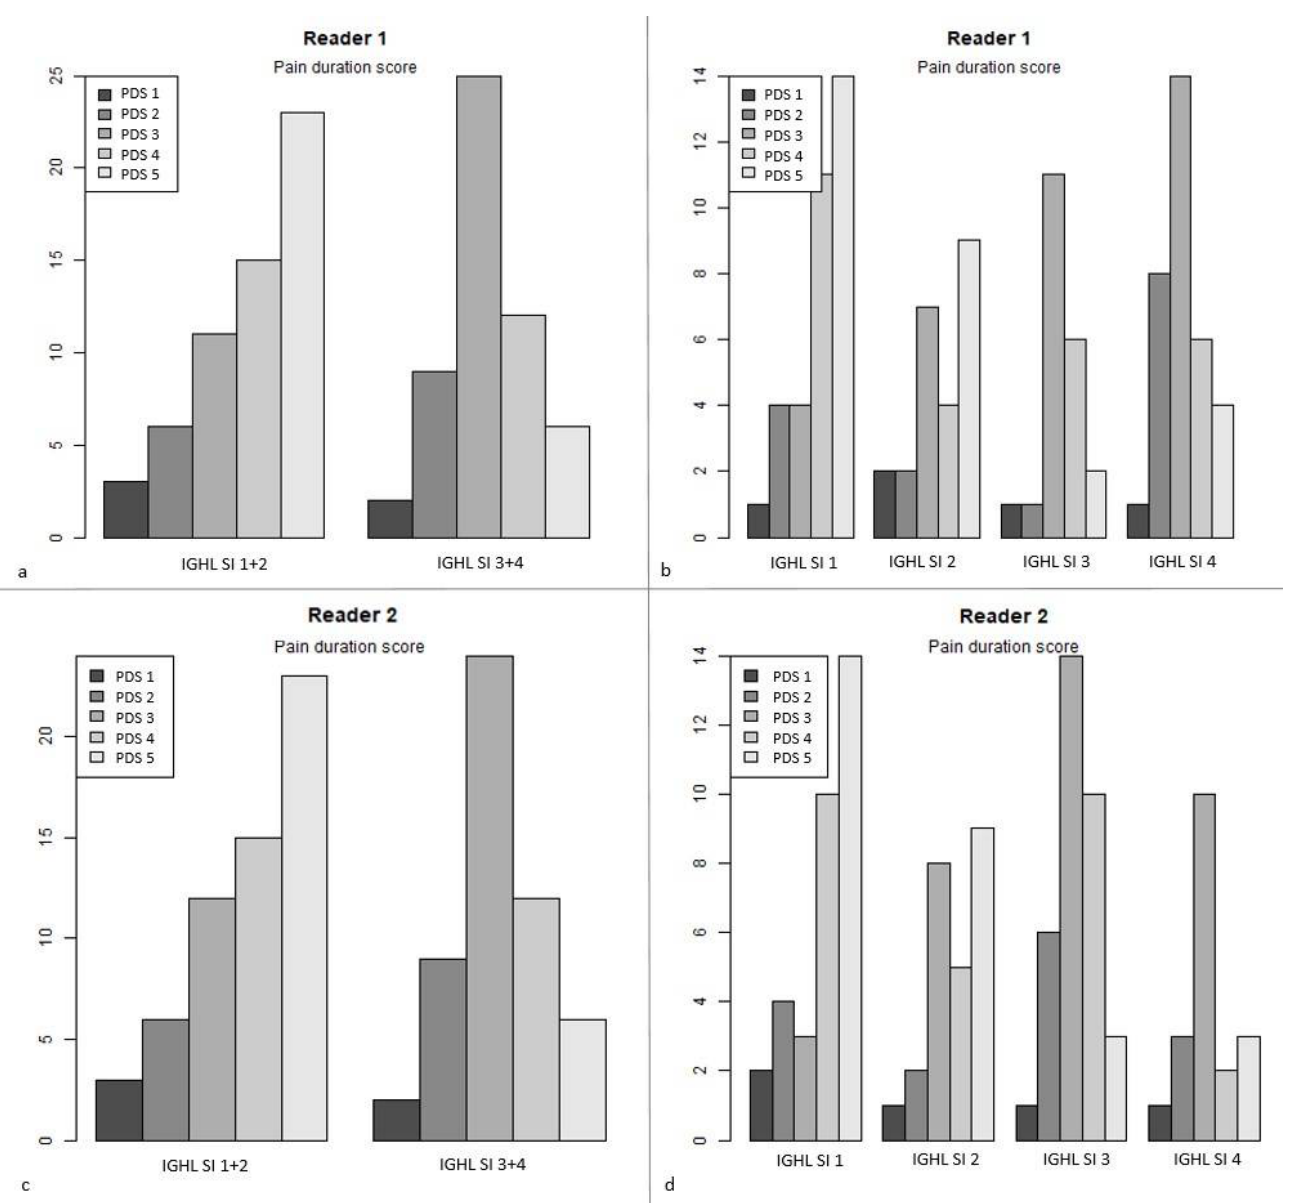
Figure 5. Bar plot representing pain score duration (PDS) (number of patients on y -axis) according to inferior glenohumeral ligament signal intensity (IGHL SI) ( x -axis), shown for reader 1 for grade 1 + 2 and 3 + 4 in ( a ), for each grade (1, 2, 3, 4) in ( b ), and for reader 2 for grade 1 + 2 and 3 + 4 in ( c ), for each grade in ( d ).